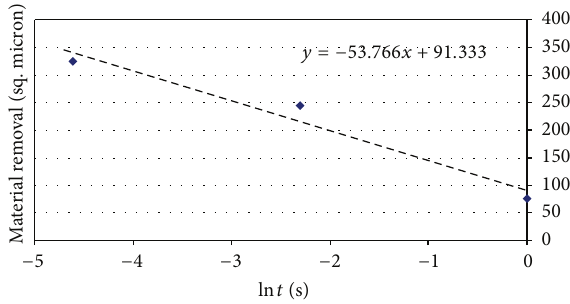
Figure 2: Variation of material removal with the logarithm of the interaction time.